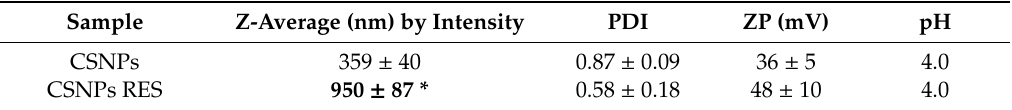
Table 2. Particle size, polydispersity index (PDI) and zeta potential of chitosan nanoparticles (CSNPs) and CSNPs resveratrol (RES).